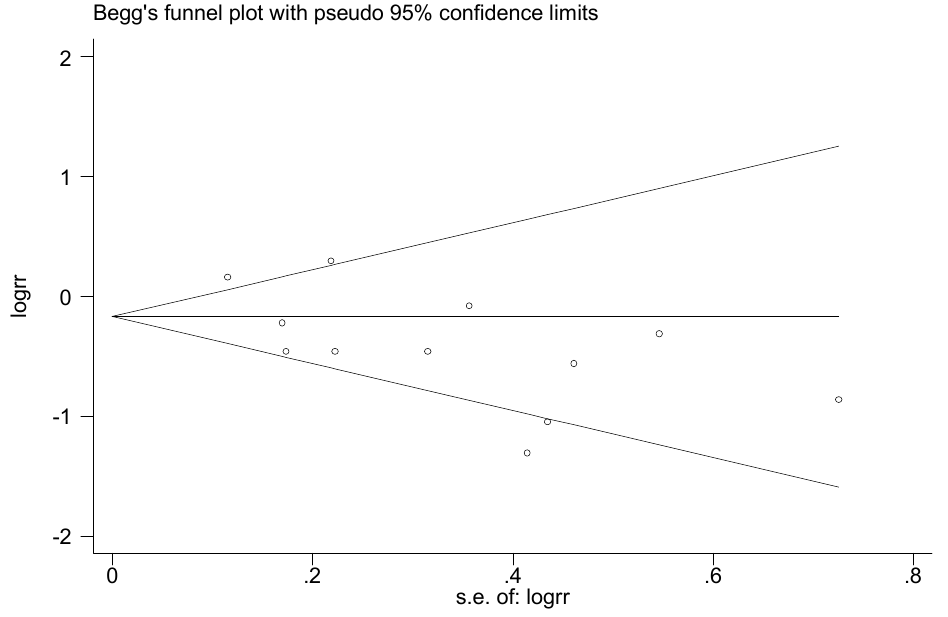
Figure A1. Funnel plot to explore the presence of publication bias.